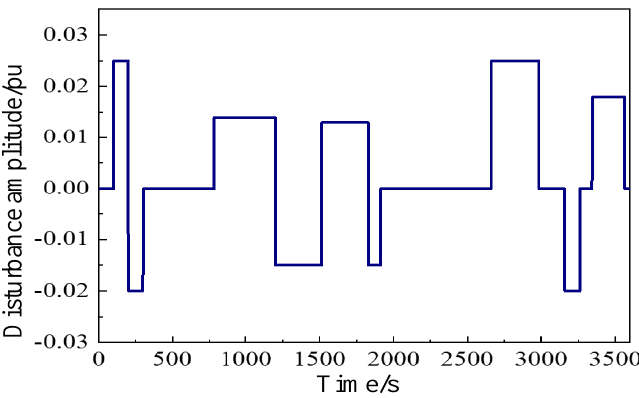
Figure 5. Continuous load disturbance.